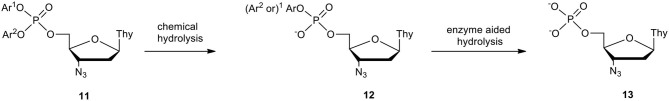
Pronucleotide metabolism in cell culture media (RPMI/FCS 10%) exemplified on AZT bis-aryl phosphotriester 11.